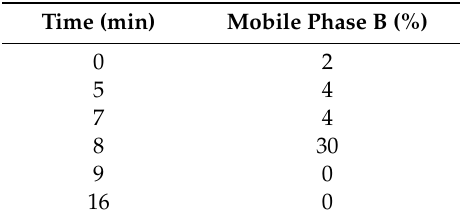
Table 1. 5’-nucleotides gradient elution conditions.